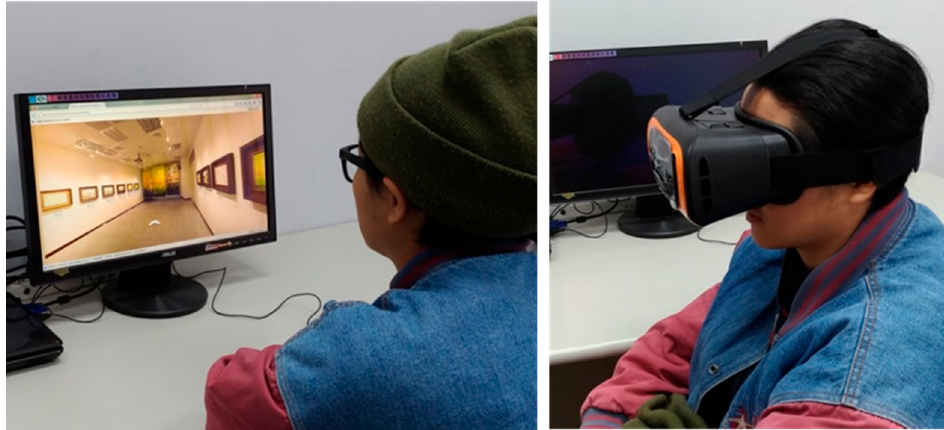
Figure 5. An interviewee is watching with Desktop VR (left) and HMD VR (right).